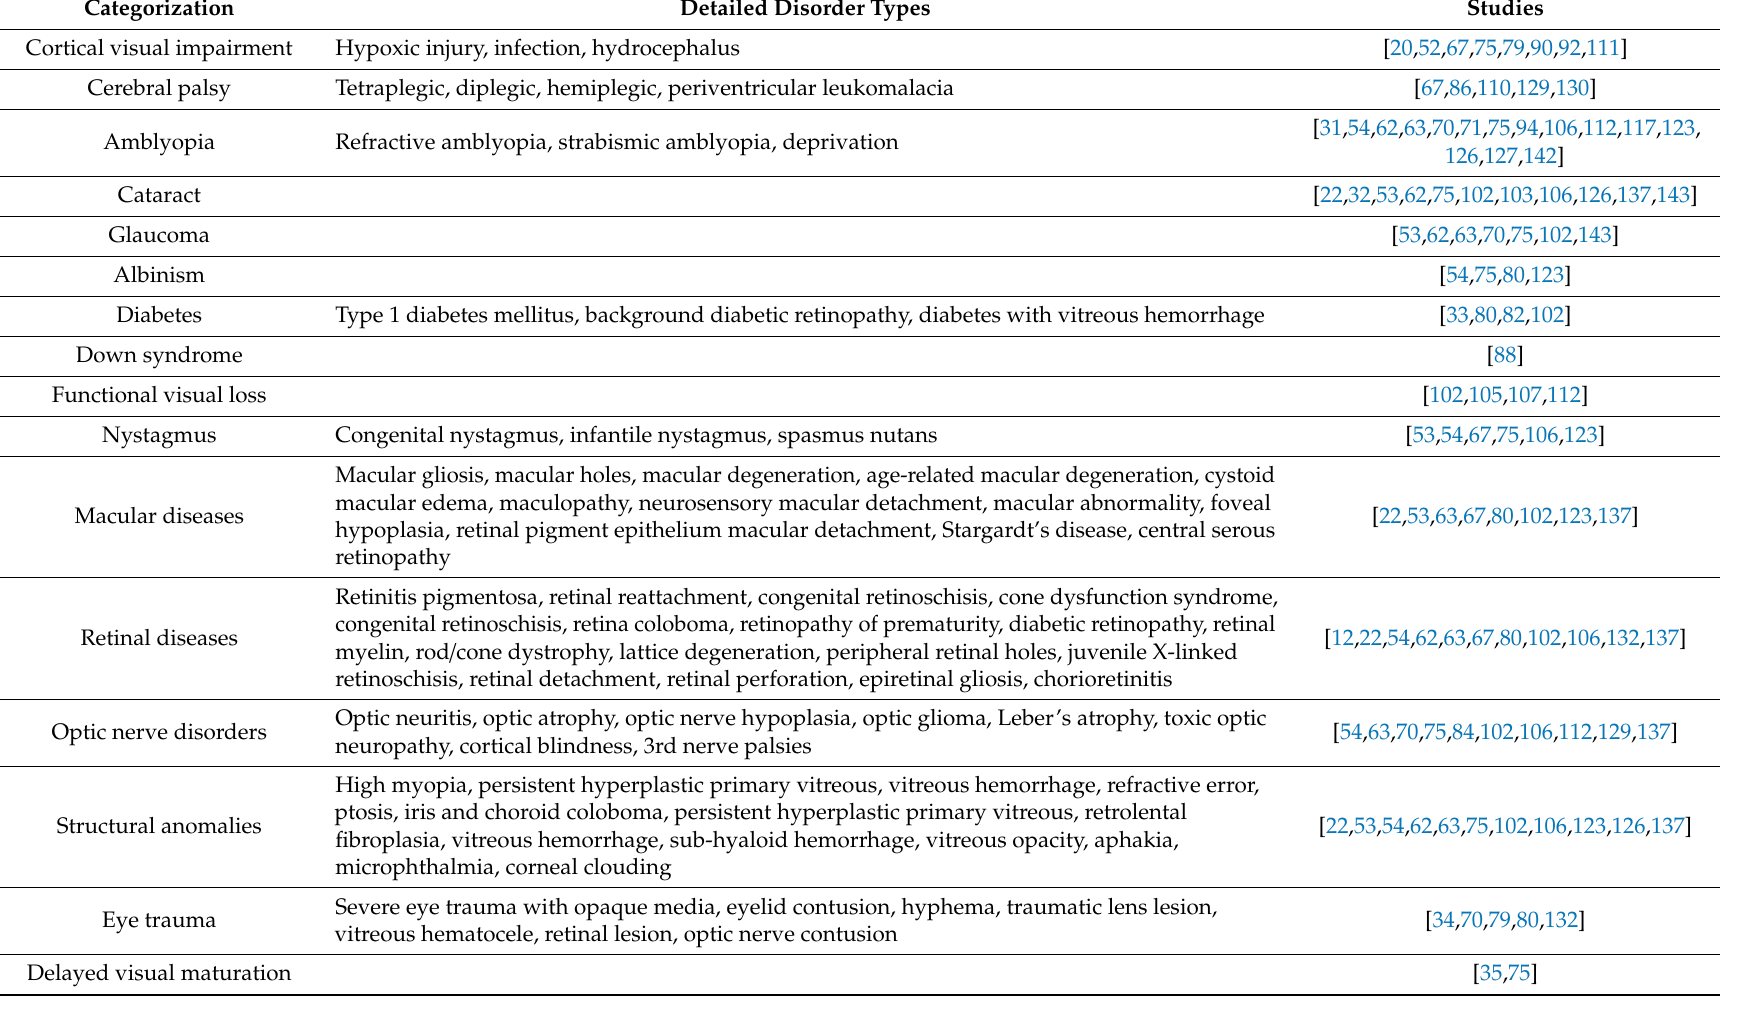
Table 3. Clinical studies of VEP acuity for visual